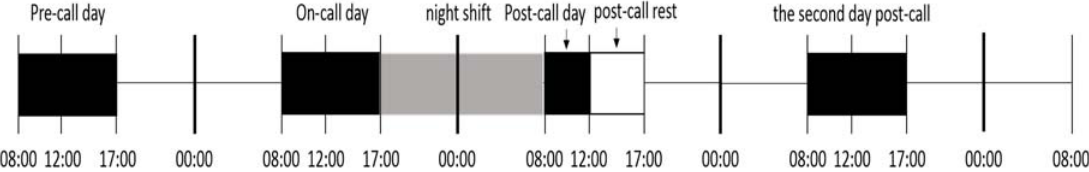
Figure 1. Participants underwent electrocardiographic (ECG) recording for a four ‐ day cycle: the pre ‐